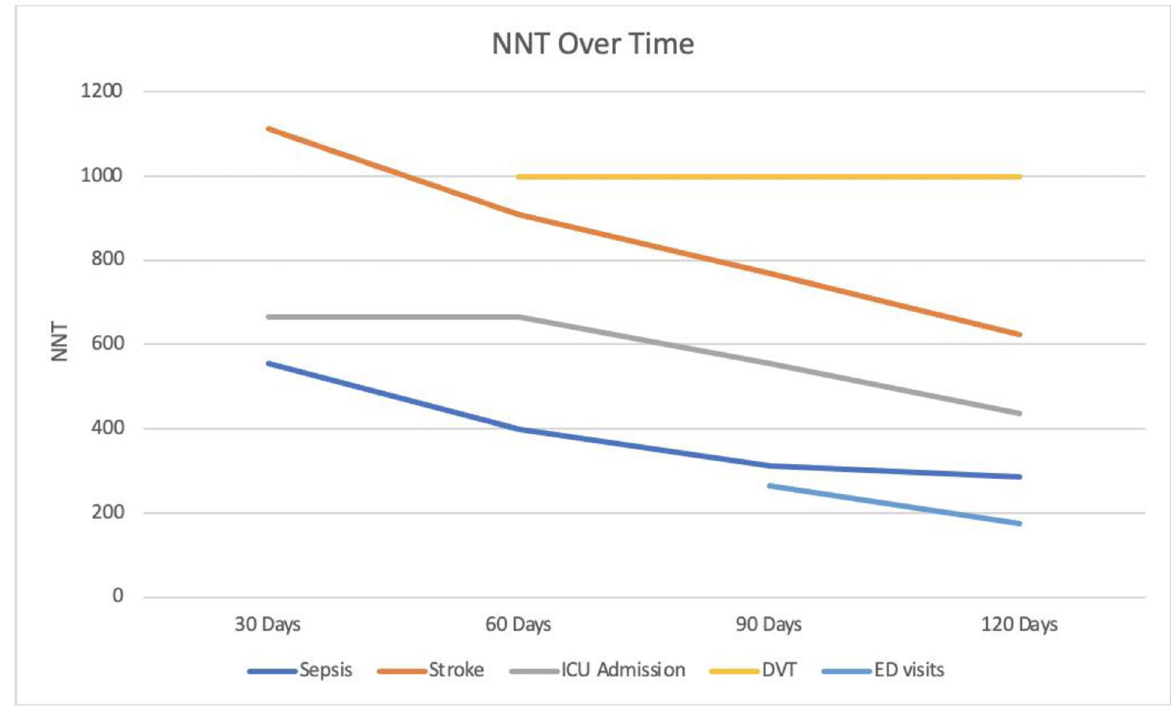
Fig 3. NNV to prevent adverse outcomes within 30–120 days, 60–120 days, and 90–120 days of SARS-CoV-2-positive diagnosis.